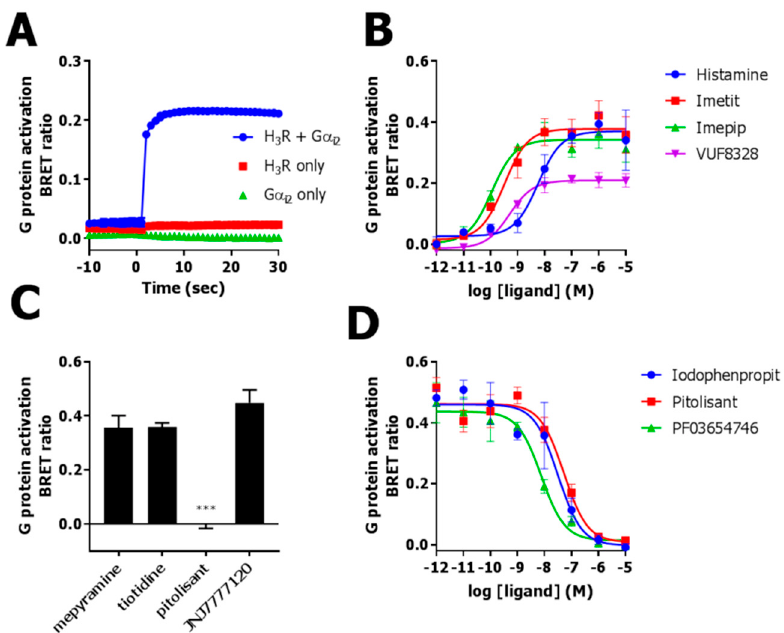
Figure 1. Human H 3 R-mediated G α i2 activation in HEK293T cells measured as bioluminescence resonance energy transfer (BRET) ratio between Venus-G β 1 γ 2 and masGRK3ct-Nluc. ( A ) Real time BRET ratio in HEK293T cells expressing hH 3 R and / or G α i2 upon stimulation with 1 µ M histamine at t = 0. ( B ) Concentration-dependent increase in BRET ratio in cells co-expressing hH 3 R and G α i2 upon stimulation with H 3 R agonists. ( C ) BRET ratio in cells co-expressing hH 3 R and G α i2 upon stimulation with 1 µ M histamine in the presence of 10 µ M histamine receptor subtype-selective antagonists. ( D ) Decrease in histamine-induced (1 µ M) BRET ratio in HEK293T cells co-expressing G α i2 in the presence of increasing concentrations H 3 R antagonists. Representative graphs of 3 experiments performed in triplicate are shown and data are mean ± SD. BRET ratio was measured after 10 min incubation ( B – D ). BRET ratios are corrected for vehicle. Significance was determined by a Student’s t-test *** ( p <